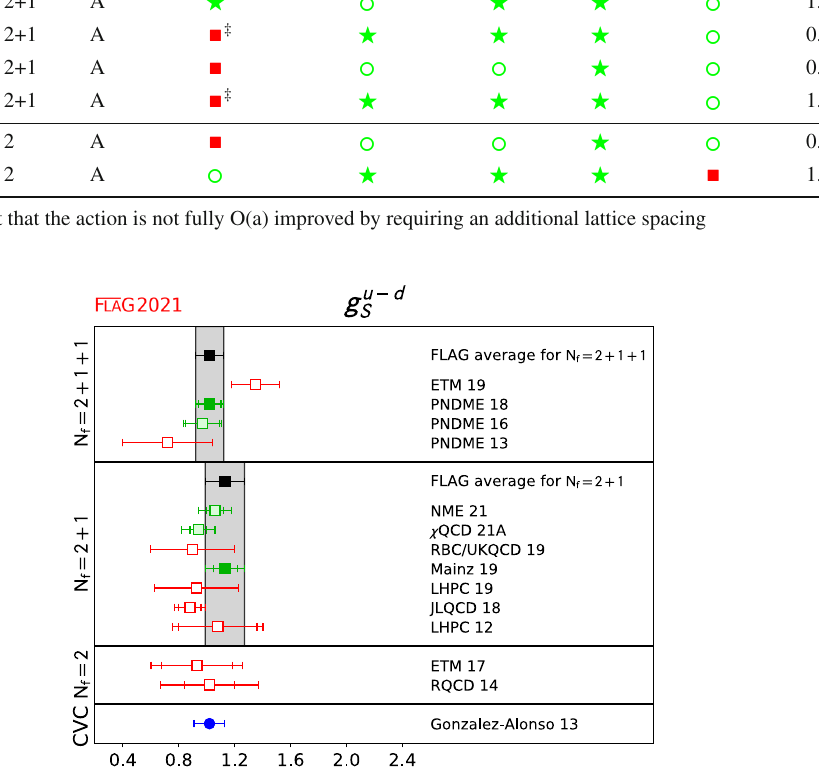
Table 70 Overview of results for g u − d